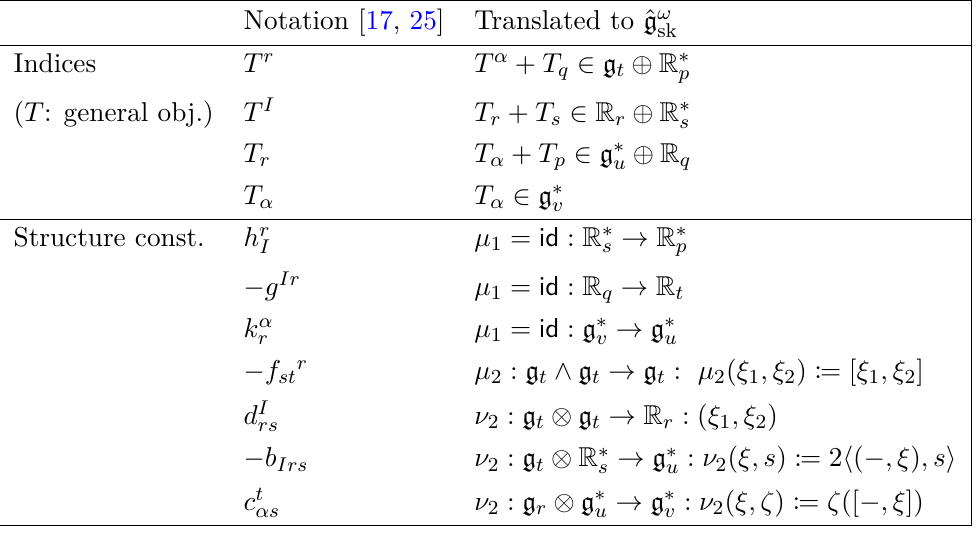
Table 3 . The relation between the structure constants employed in [17, 25, 26] and our EL ∞ - algebra